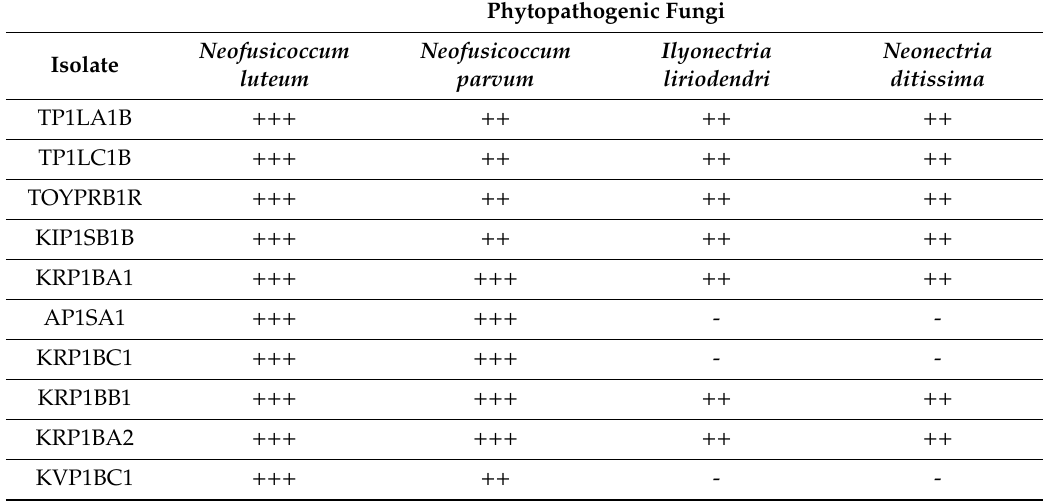
Table 2. Activity of select endophytic bacteria isolated from P. colorata against fungal phytopathogens. Activity was assessed as high activity ( +++ ) where growth was completely inhibited, moderate activity ( ++ ), low activity ( + ), no activity (-).